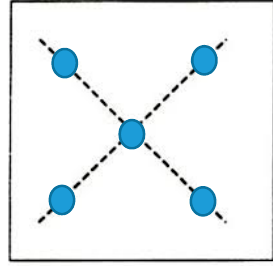
Figure 2. Soil sampling scheme.